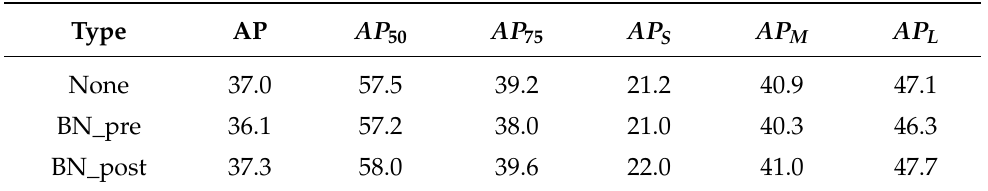
Table 4. Ablation studies of BN method on COCO val2017.